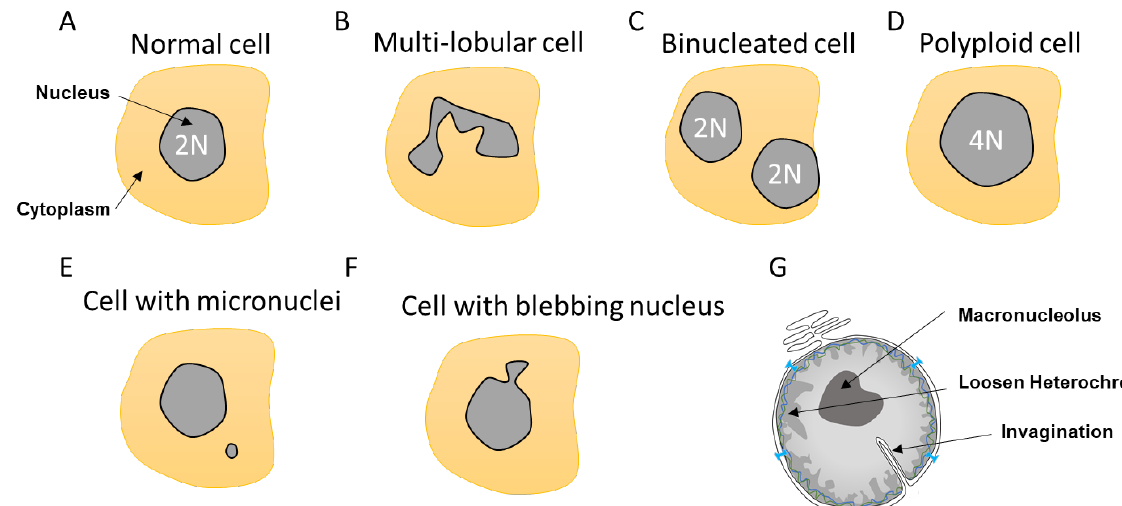
Figure 2. Different nuclear abnormalities. ( A ) Classical cells have one single round nucleus that contains a diploid genome (2N). ( B ) Cells such as neutrophils possess multi-lobar nucleus. ( C , D ) Polyploid cells (>4N) can either have two or more separated nuclei or one enlarged nucleus. ( E ) Some cells can have a smaller nucleus, which is called a micronucleus, in their cytoplasm. Micronuclei contain a full chromosome or a piece thereof. ( F ) Nuclei can also display blebbing characterized by an outward extension of the nuclear envelope (NE). ( G ). In addition, cancer cells can show abnormalities such as NE invagination, loosen heterochromatin as a consequence in changes in DNA compaction as well as a single and bigger nucleolus, which is called a macronucleolus.